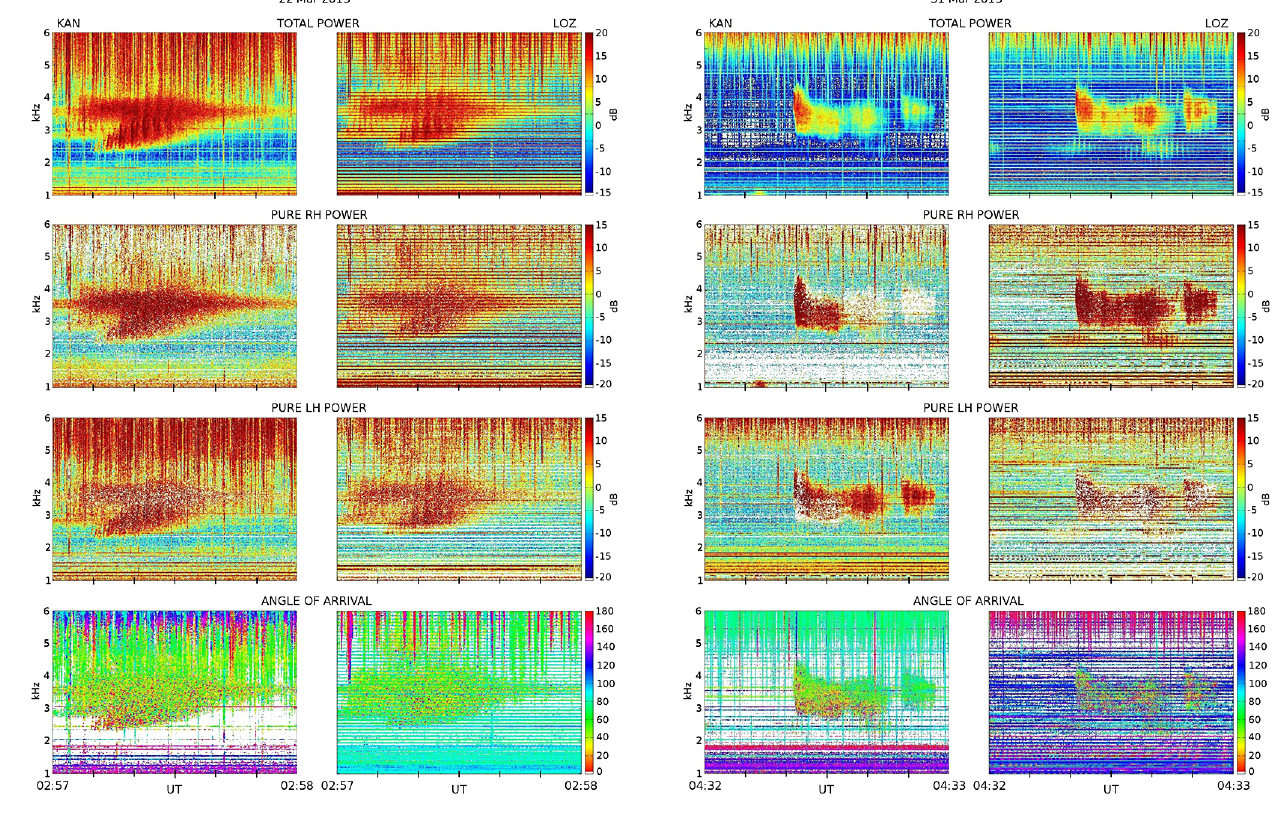
Figure 5. A VLF event with complex spectral structure observed at KAN and LOZ at 02:57–02:58UT on 22 March 2013.